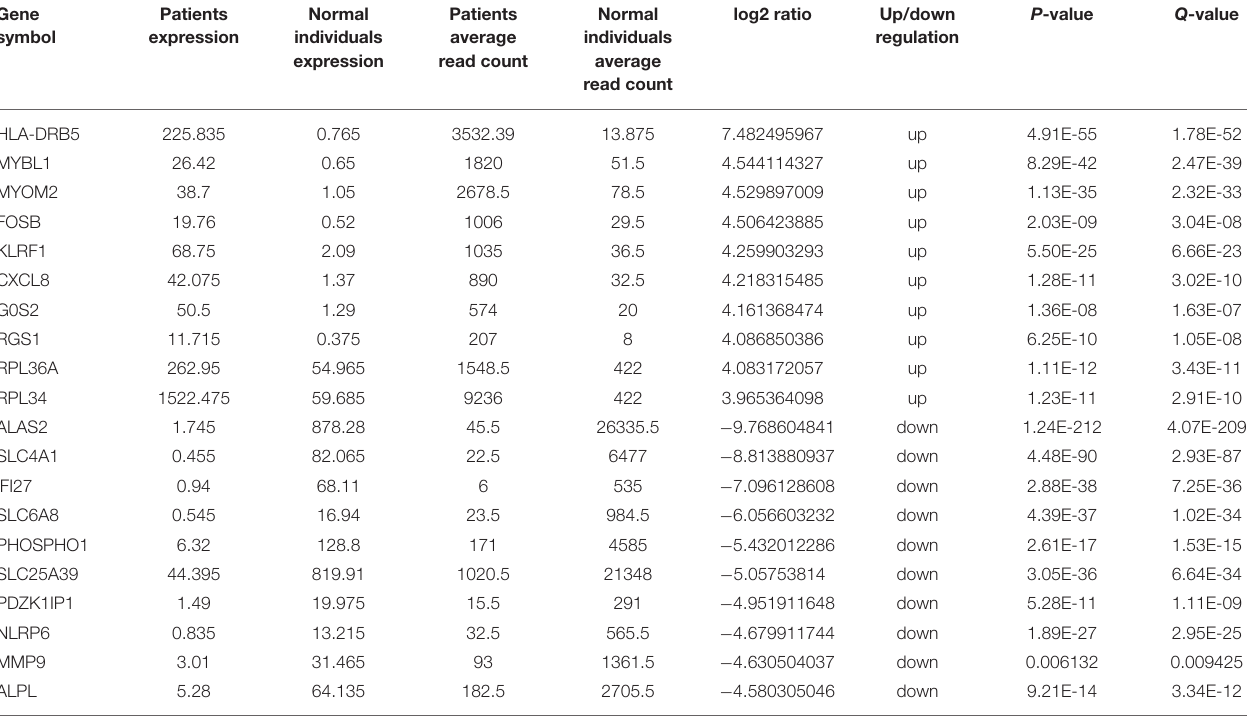
TABLE 1 | Top 10 upregulated and 10 downregulated mRNAs between the patients and normal individuals. Gene